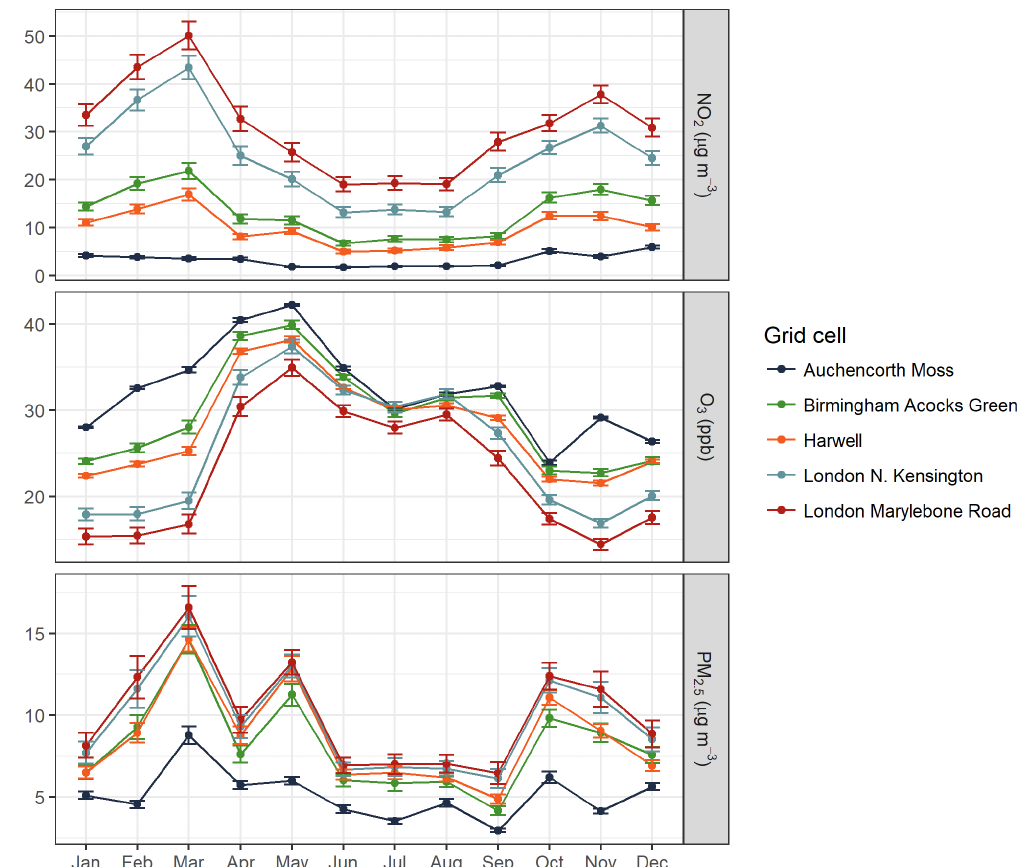
Figure 6. Monthly average surface concentrations of NO 2 , O 3 , and PM 2 . 5 , with error bars showing (absolute) uncertainty, for five grid cells across the UK representing a spread of geographical locations and environment types. The environment types are assigned as follows: Auchencorth Moss and Harwell – rural background; Birmingham Acocks Green and London N. Kensington – urban background; and London Marylebone Road – urban